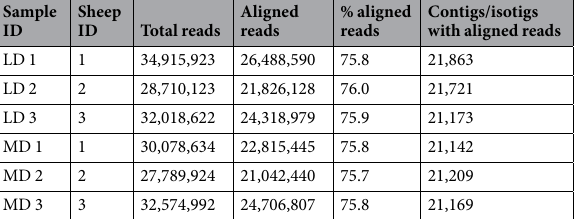
Table 1. Total number of Illumina Solexa Hi-Seq reads for each of the six RNA sample sets mapping to each contig/isotig of the T. circumcincta transcriptome. LD = lumen-dwelling larvae; MD = mucosal dwelling larvae.